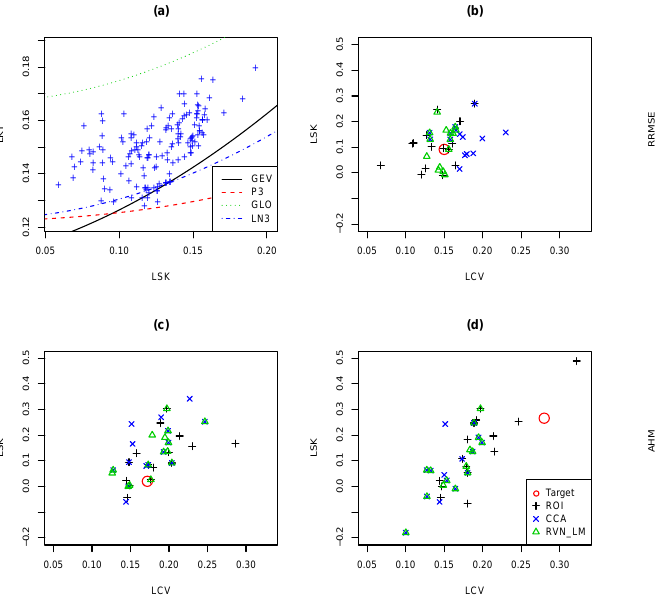
Figure 6. Evaluation criteria for the index-flood model. Calibrated models are represented by